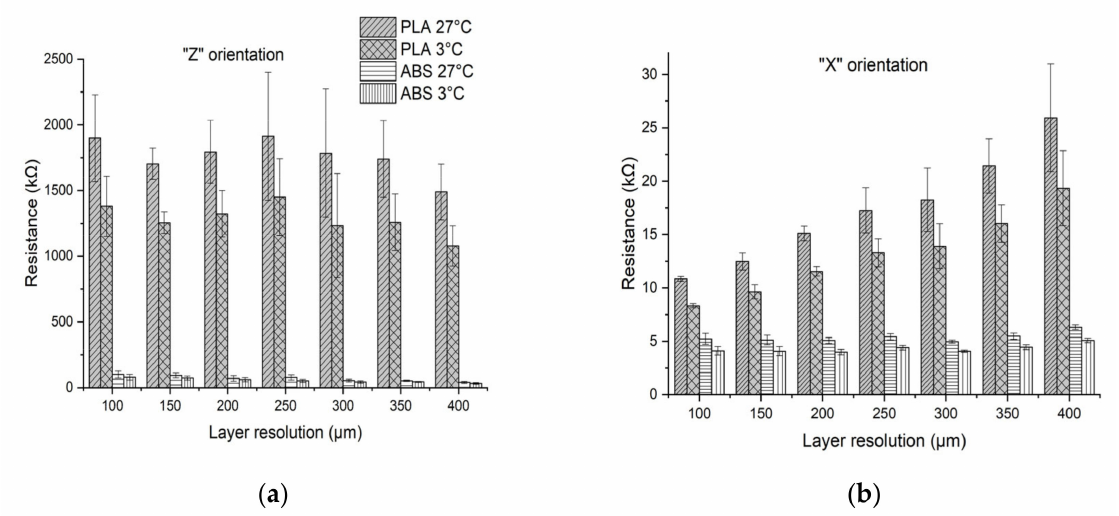
Figure 2. The e ff ect of the layer height and temperature on electrical resistance. The test bars indicate the mean with the standard deviation of the measured resistance values. On the left ( a ), the results of the Z printing orientation, and on the right ( b ), the results of the X printing orientation are